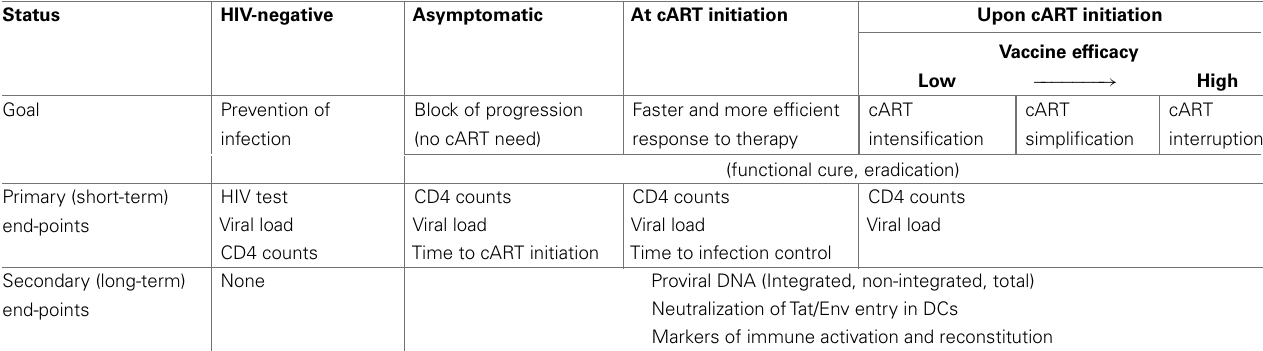
Table 2 | HIV/AIDS preventative and therapeutic vaccine ... the continuum